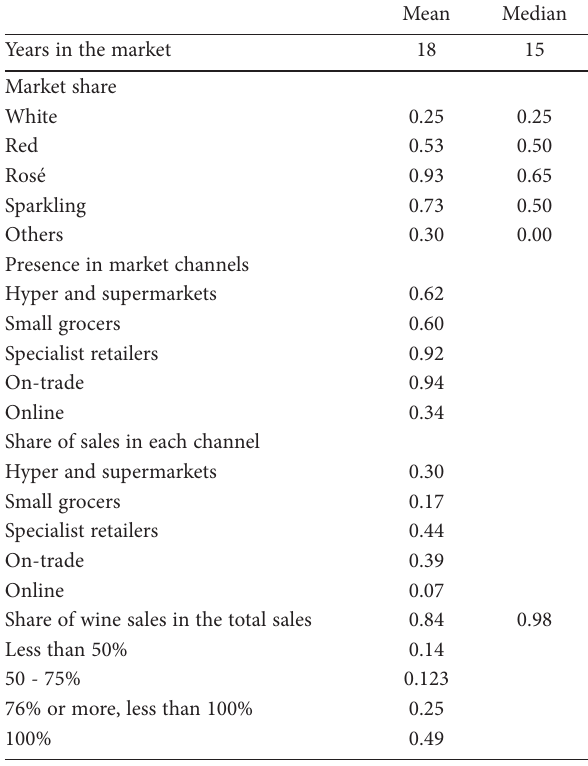
Table 1. Distributor’s business